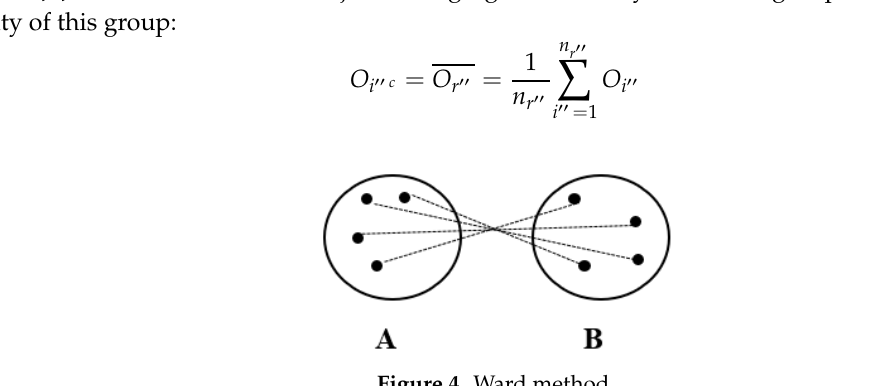
Figure 4. Ward Figure 4. Ward method.